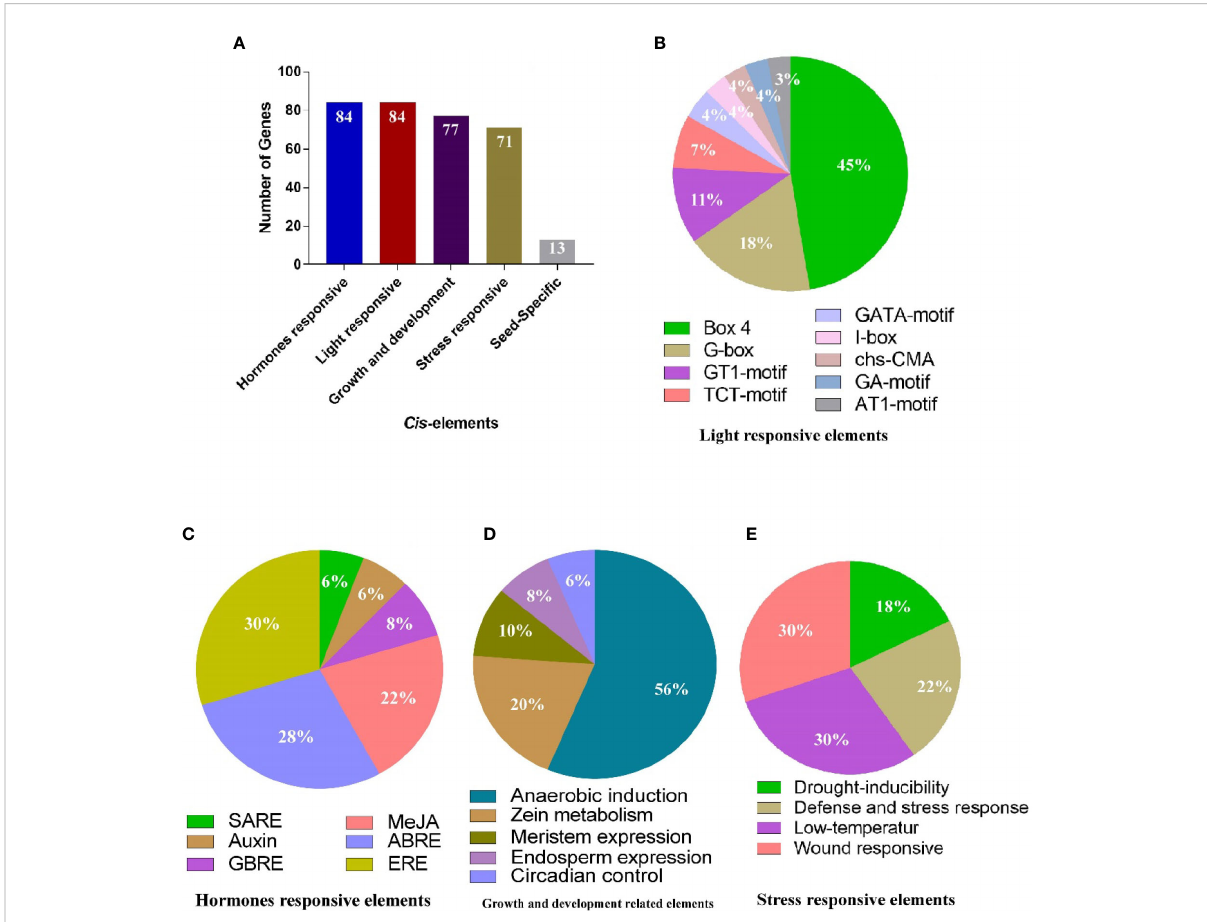
FIGURE 7 Cis -regulatory elements of AhGLP promoters. (A) the number of genes in different categories of elements. (B) composition of light-responsive, (C) hormone-responsive, (D) growth and development responsive, and (E) stress-responsive